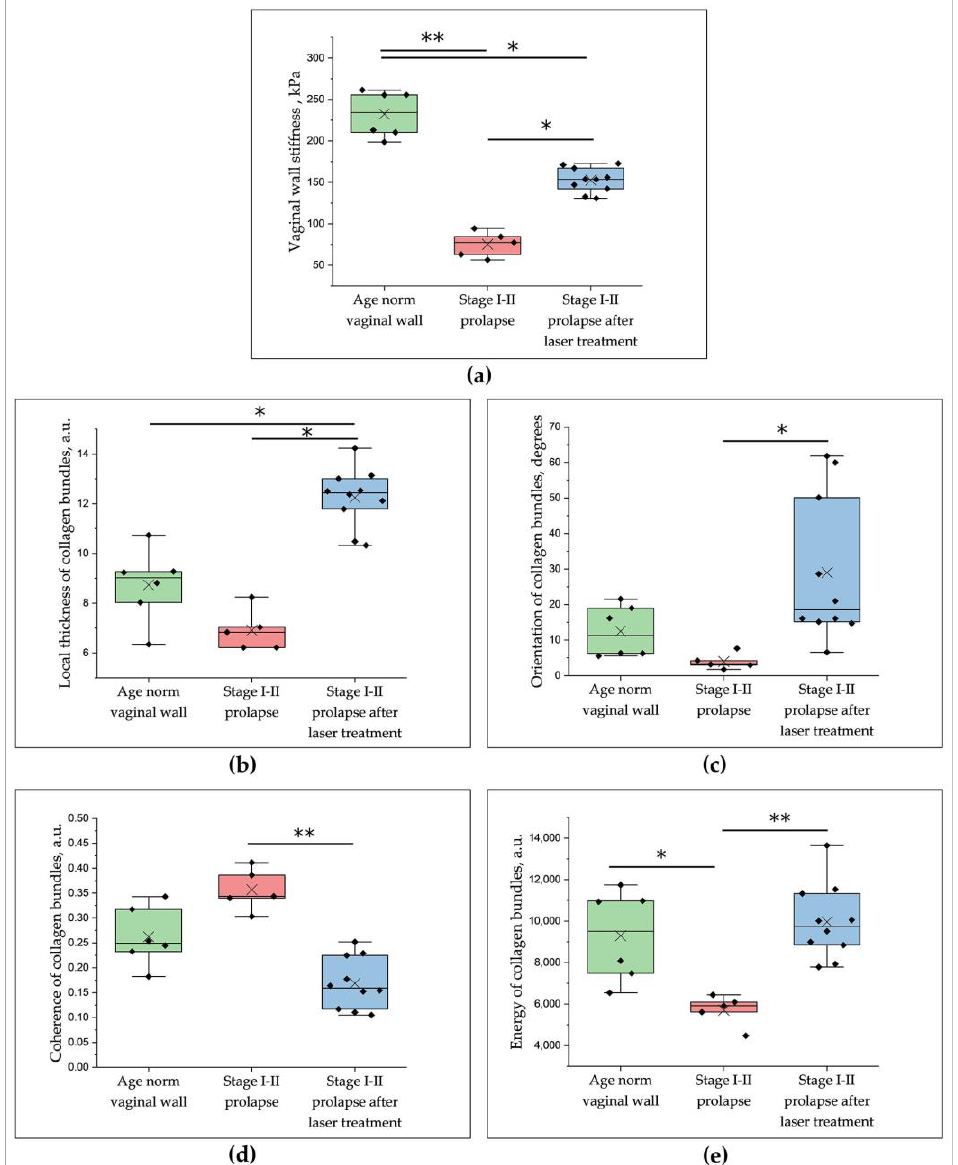
Figure 5. Quantitative assessment of C-OCE ( a ) and collagen bundles structure parameters ( b – e ) in three conditions of the vaginal wall: age norm, stage I–II prolapse and stage I–II prolapse after a course of Nd:YAG laser treatment. ( a ) Box plot of mean stiffness according to C-OCE data; ( b ) box plot local thickness of collagen bundles according to Van Gieson histological stain; ( c ) box plot orientation of collagen bundles according to Van Gieson histological stain (values are expressed modulo); ( d ) box plot organization (coherency) of collagen bundles according to Van Gieson histological stain; and ( e ) box plot uniformity (Energy) of collagen bundles according to Van Gieson histological stain. For each box plot, the center line represents medians, and “ × ” is the mean value of the analyzed parameter. Box plot limits indicate lower/upper quartiles (25th and 75th percentile), whiskers are minimum/maximum values within the 1.5 × interquartile range of the first and third quartile, and notches are approximate 95% confidence intervals of the median. Segment indicates a statistically significant differences between the study groups, * and ** statistically significant ( p < 0.05 and p < 0.001, respectively) (Mann–Whitney U test with Bonferroni correction). a.u.—arbitrary units. Numerical assessment of the elasticity of the vaginal wall prolapse showed that the vaginal wall prolapse is characterized by a statistically significant decrease in